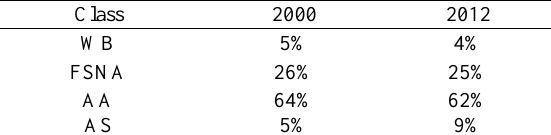
Table 4. Distribution of land use / cover classes in generalized images